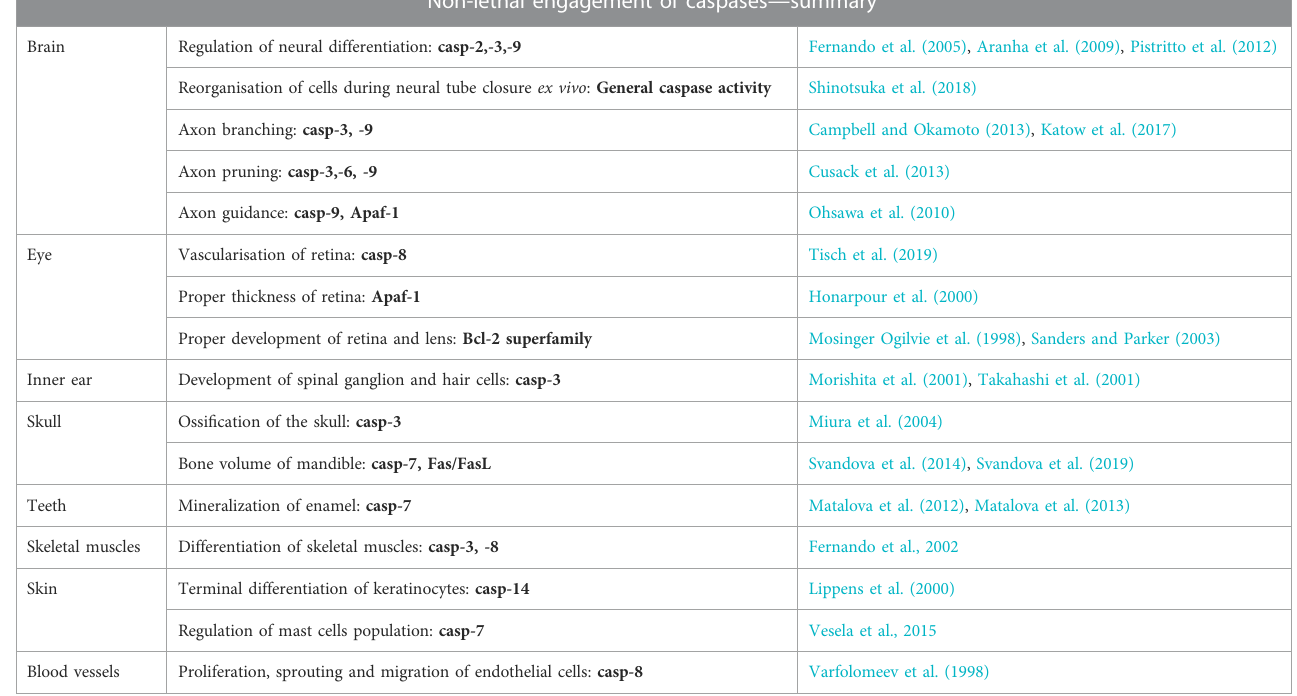
TABLE 3 Overview of caspase non-lethal functions during development of head. Non-lethal engagement of caspases —